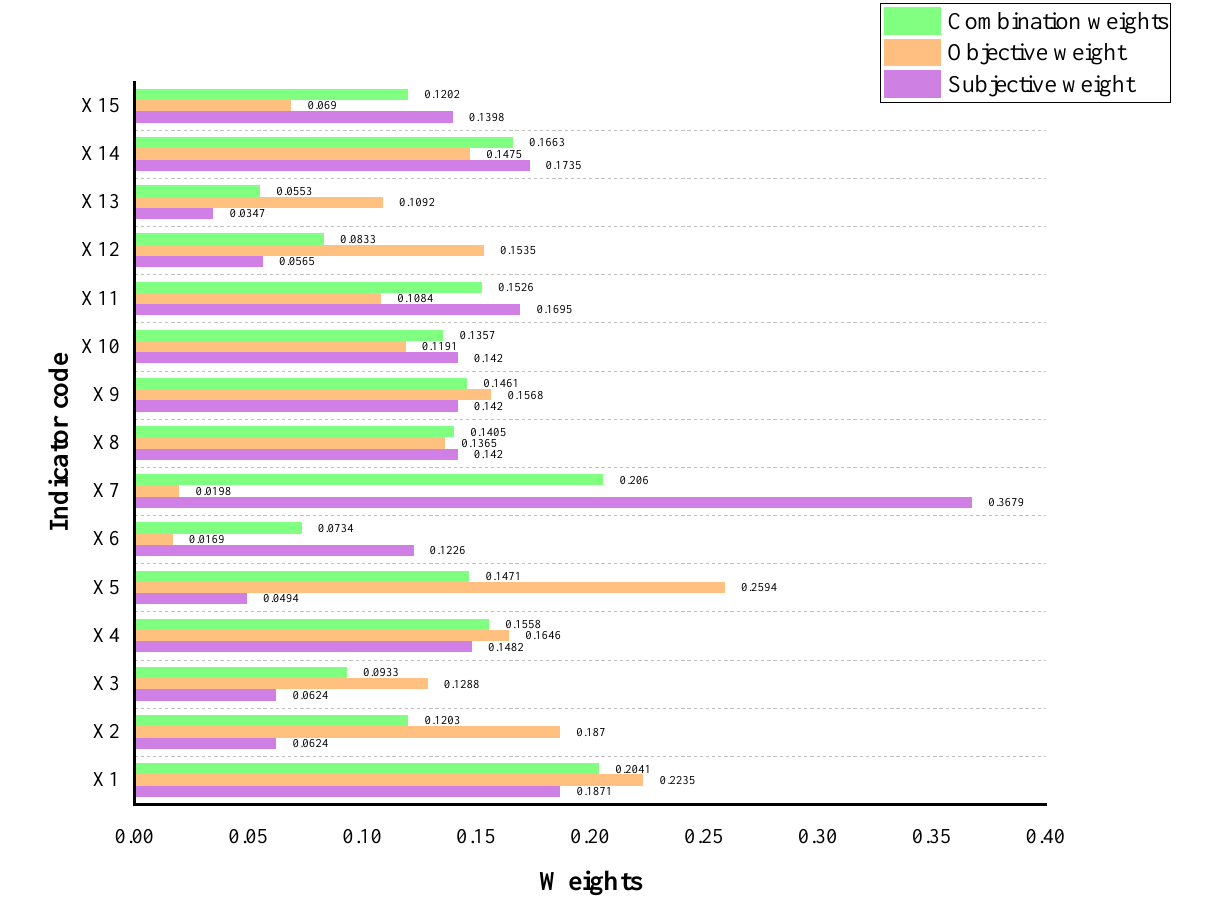
Figure 3. The weight of the evaluation indicator.